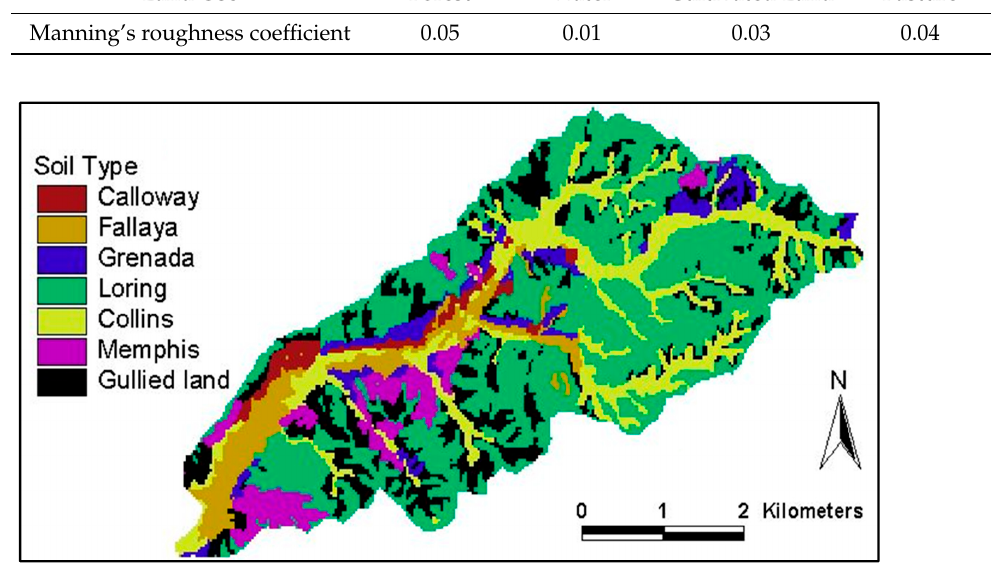
Figure 18. The soil types of the watershed. Table 2. Infiltration coefficients of different soil types.